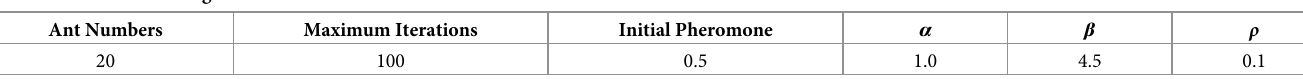
Table 1. Parameters settings.